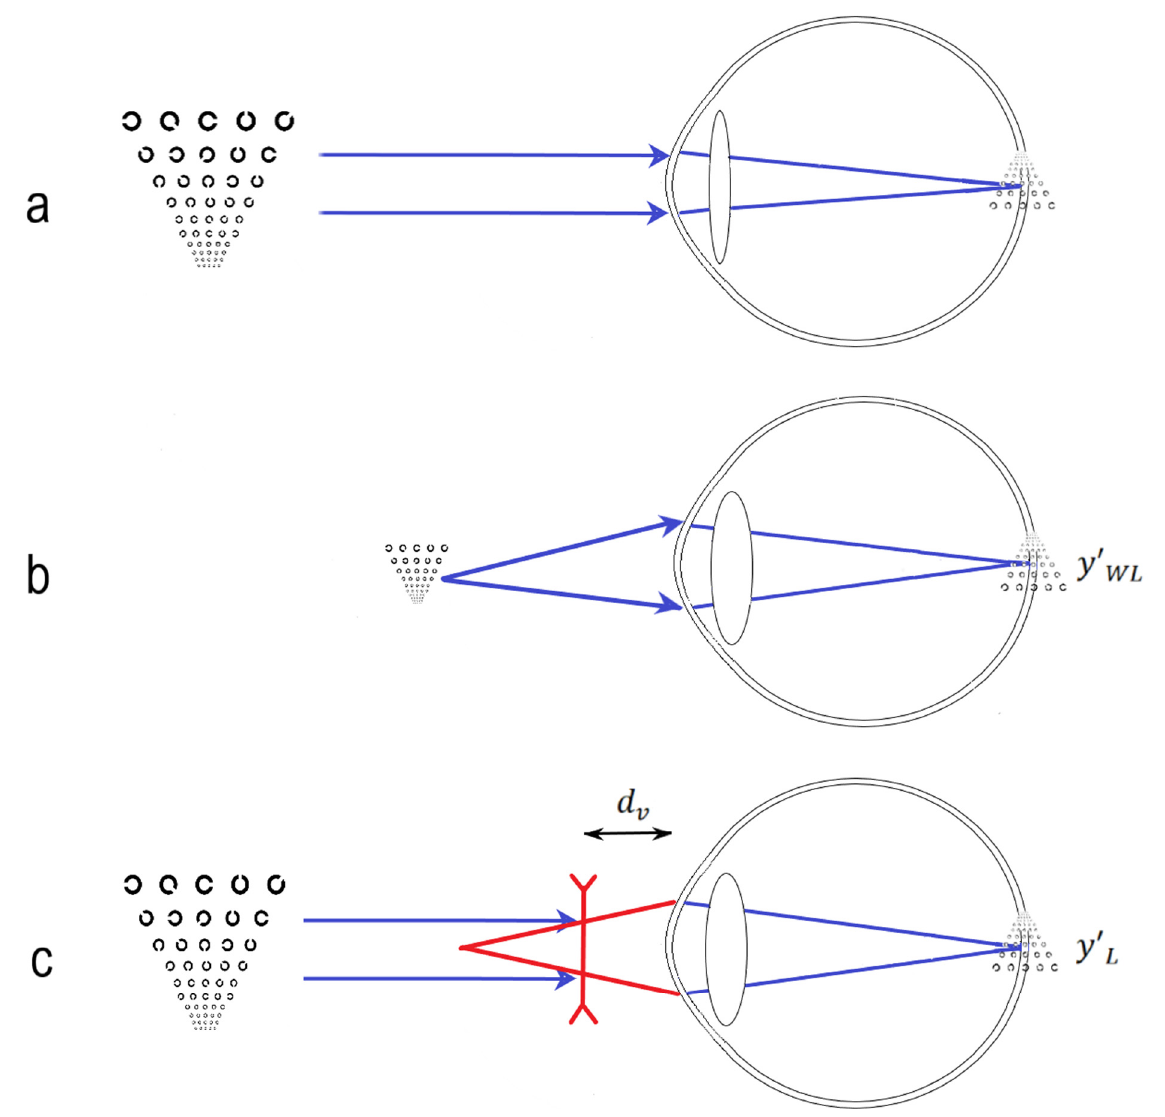
Figure 1. Visual observation of a C-Landolt test chart by an emmetropic young phakic eye with accommodation preserved in different circumstances: ( a ) far vision with the optotype in infinity. The retinal image is in focus; ( b ) near-vision, with the optotype at a near distance. The eye accommodates sufficiently to bring the image of size y (cid:48) WL to focus onto the retina; and ( c ) near-vision, with the optotype in infinity and a minus trial lens placed at d v from the eye vertex. The virtual image that is formed by the lens simulates a near object vergence. Eye accommodation brings the final image to focus onto the retina, now with size y (cid:48) L .